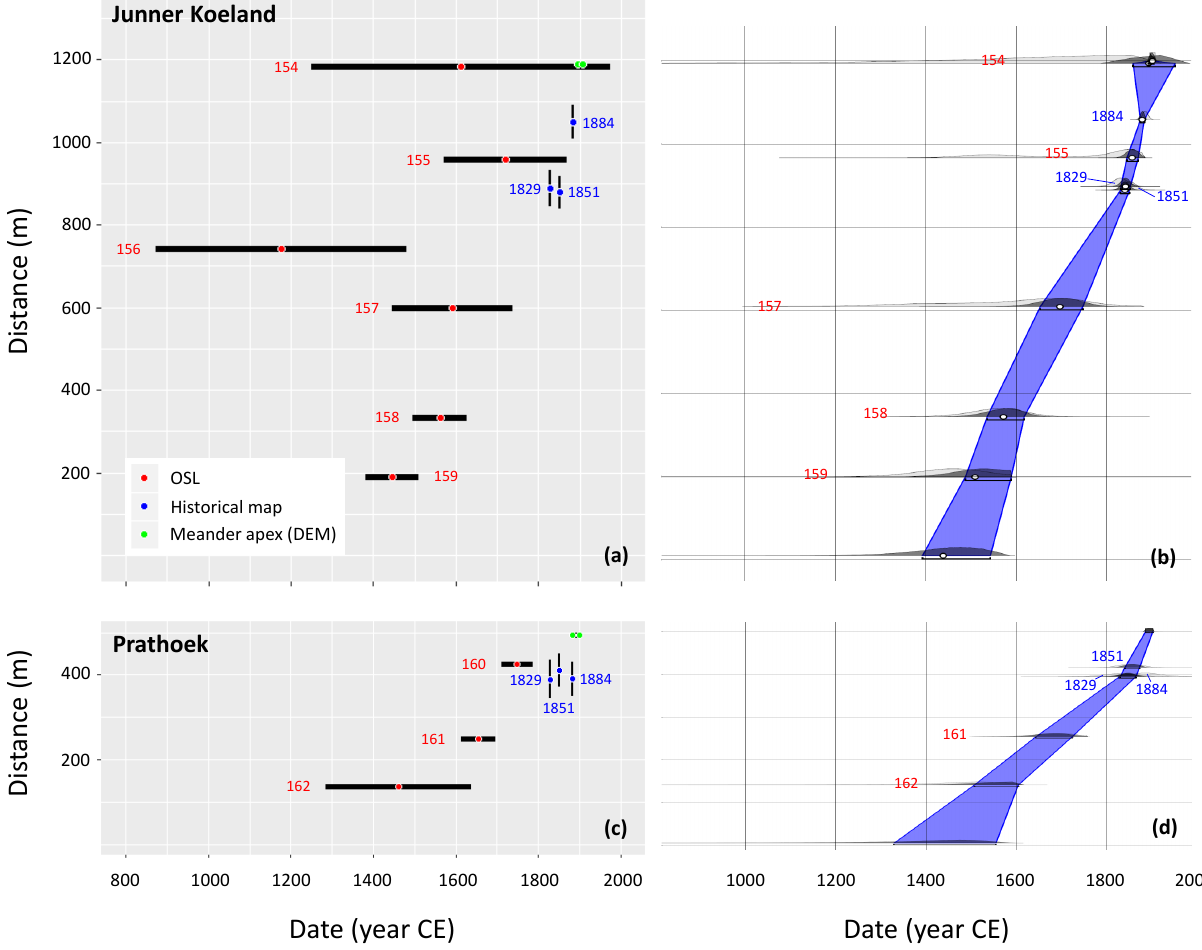
Figure 7. Comparison of results before (a, c) and after (b, d) the Bayesian modelling for Junner Koeland (a, b) and Prathoek (c, d) . Panels (a) , (b) and (c) , (d) have equal y axes, and panels (a) , (c) and (b) , (d) have equal x axes. The legend in panel (a) also applies to panel (c) . In panels (a) and (c) the historical map data are indicated with error bars displaying RMSE of the georeferencing procedure (in m); the OSL results of the bootstrapped Minimum Age Model indicate the modelled mean and 1 σ error bar (in years). In panels (b) and (d) the blue areas in the Bayesian models indicate the 68.2% confidence interval. The data point indicating the meander base in panels (b) and (d) is calculated through extrapolation by the Bayesian model. The slope of the graphs in panels (b) and (d) indicates lateral migration rate. Red numbers indicate OSL samples (all should be preceded by NCL-2415). Blue numbers indicate the age of the historical maps (years CE) as used in the Bayesian